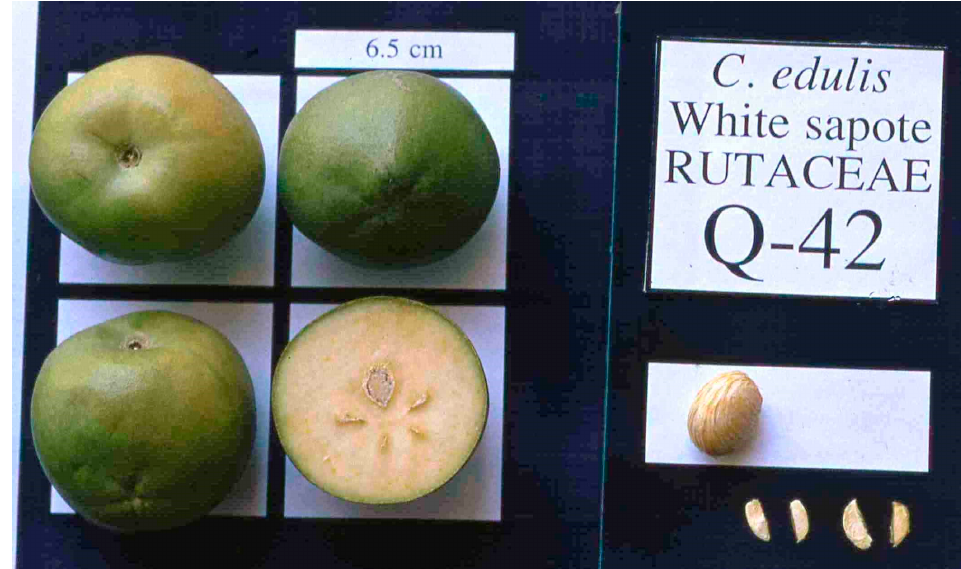
Figure 5. Appearance of the selected white sapote clone with a small number of developed seeds.